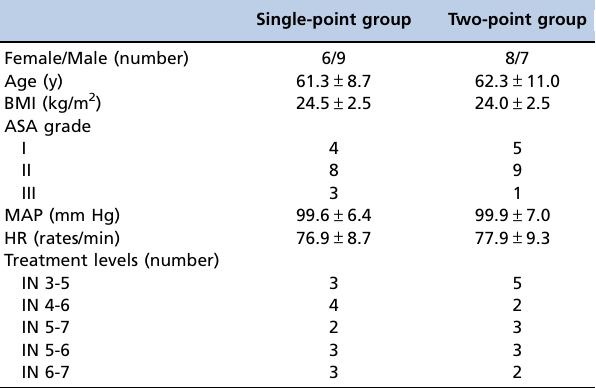
Figure 3 - Flow diagram of the randomized controlled Table 1 - General data (mean ± SD, n=15).